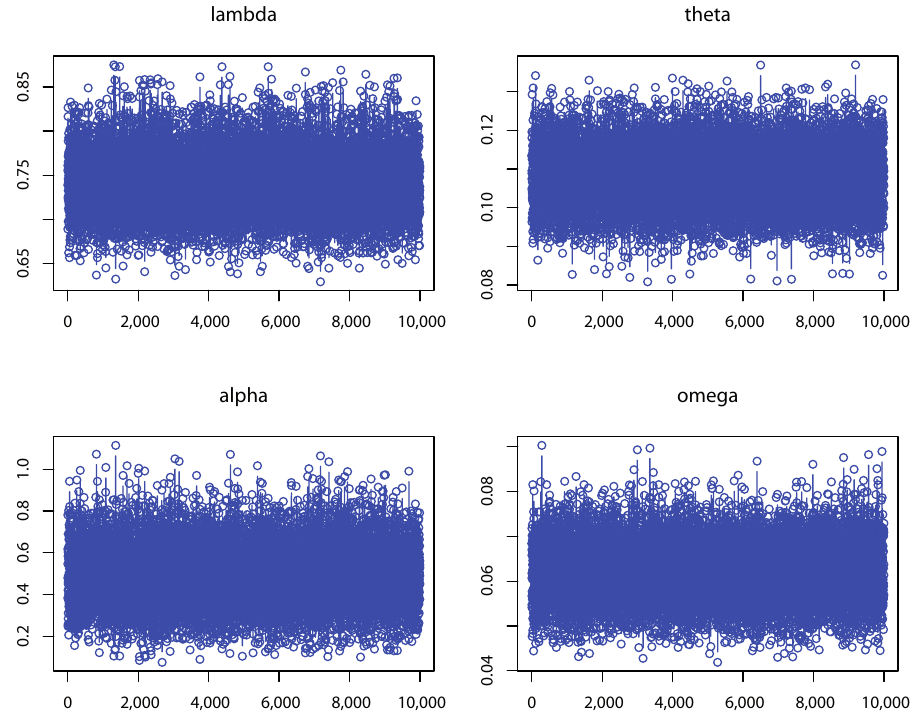
Figure 6. Plots of Bayesian analysis and performance of Gibbs sampling for DS1 dataset. Trace plots of each CWE distribution